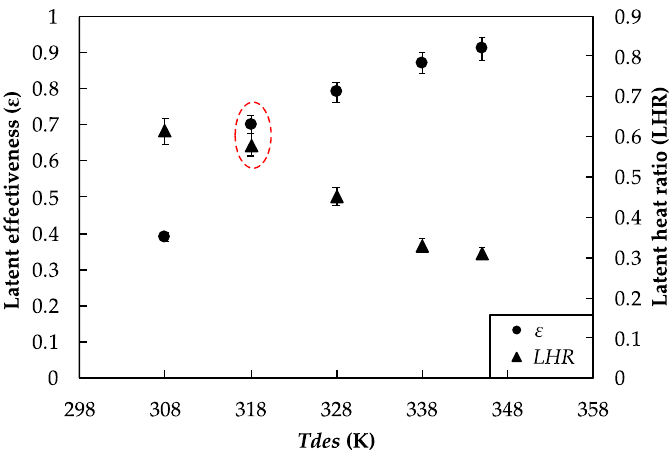
Figure 5. Latent heat effect on the performance of the system under various desorption temperatures.